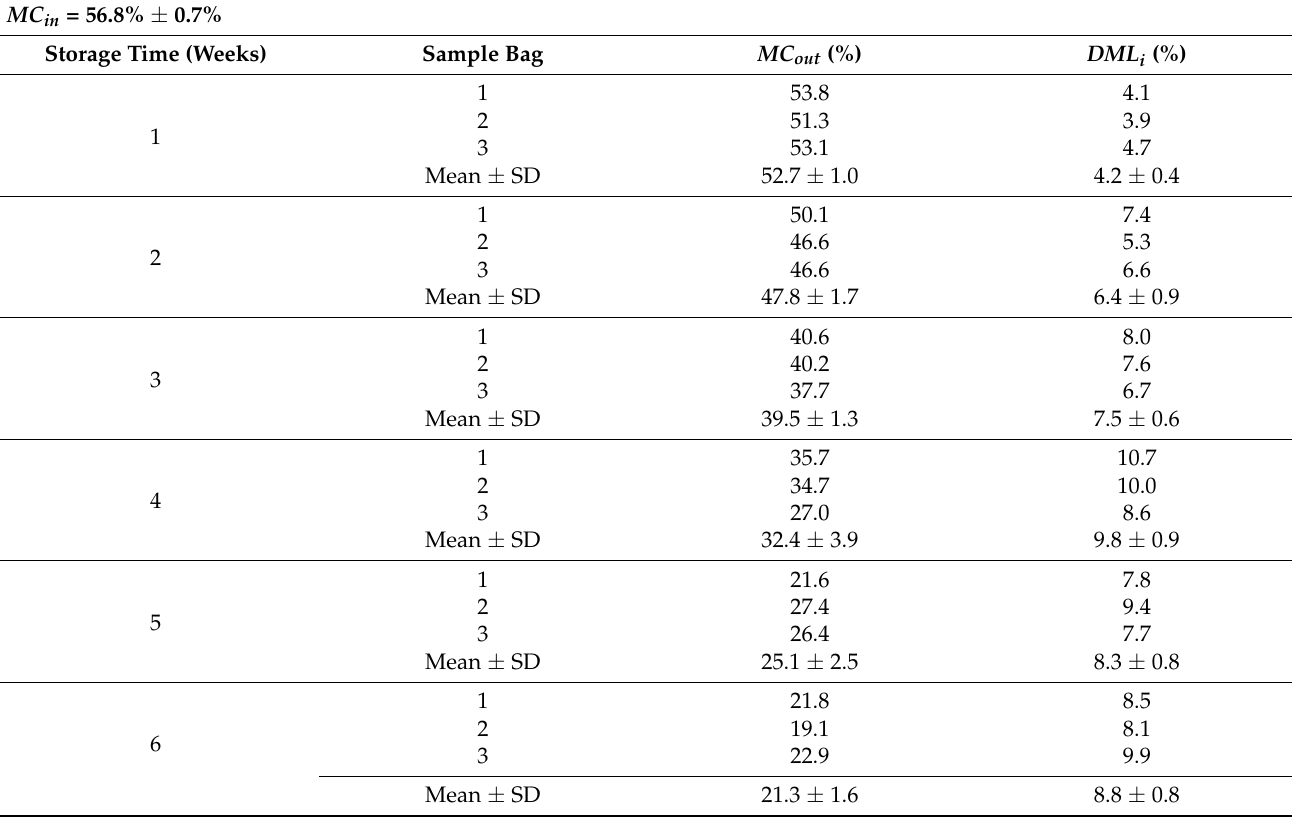
Table A1. Moisture content and dry matter losses of the sample bags in trial T1.